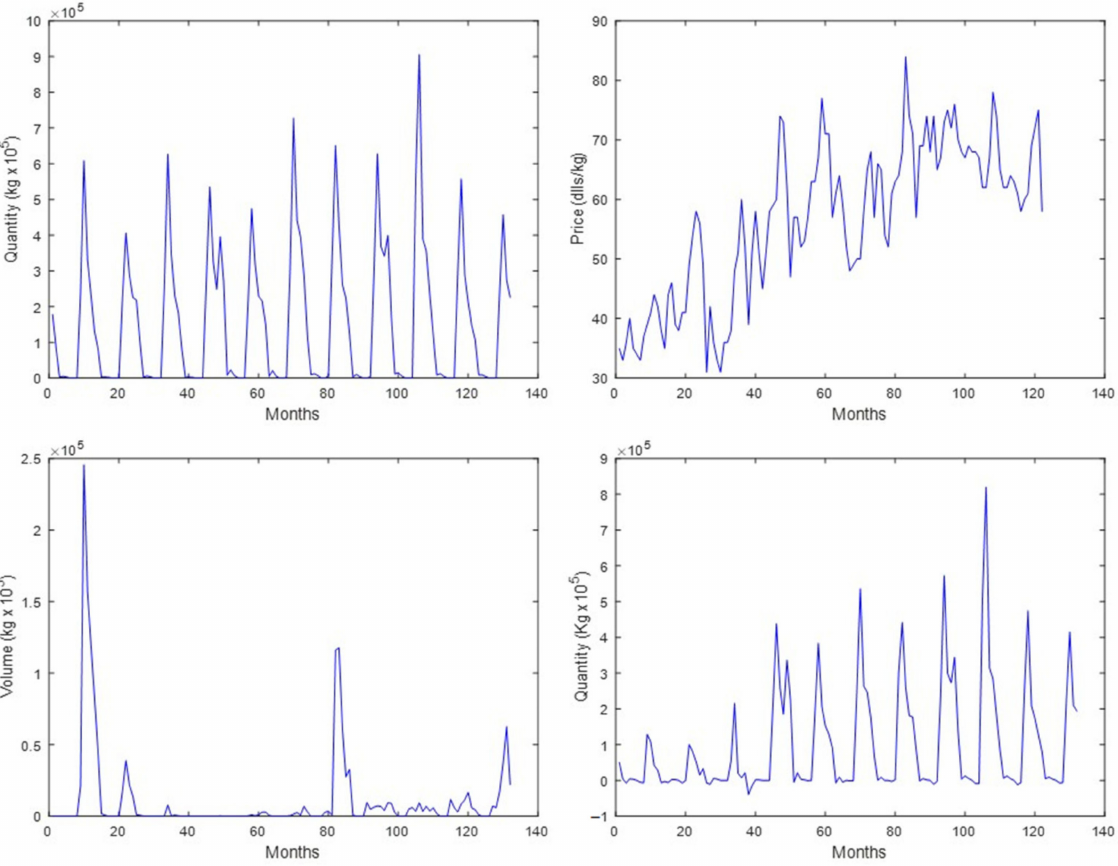
Figure 4. Historical monthly series of selected exogenous variables—PMex, PAusMun, VMexHK, and CNAMex—for the period January 2006 to December 2016.